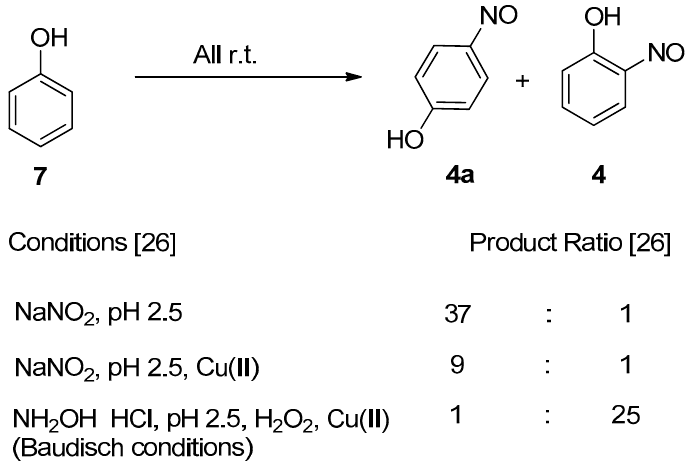
Figure 6. The results published by Maruyama [26], which appear to contradict other results from Konecny (not quantified), who instead implied that ortho -nitrosation dominated for conditions comparable to the ‘NaNO 2 , pH 2.5, Cu(II)’ shown [43]. The product ratios were calculated by obtaining the isolated ligand, then reacting with Cu(II) salt, separation via a preparative TLC method and finally, quantification via absorbance measurements.